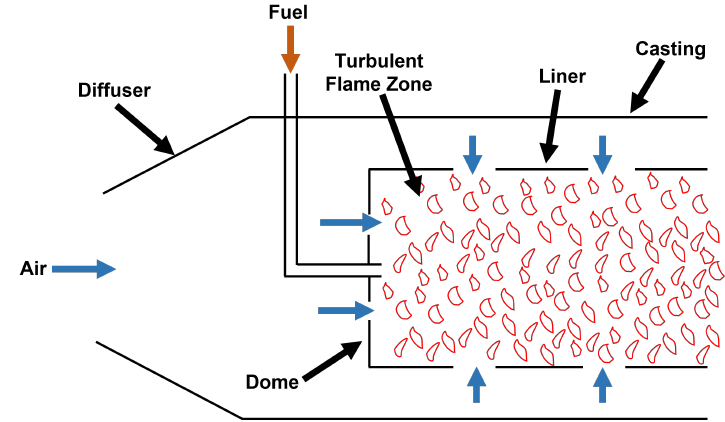
Figure 4. The physical model of Lefebvre’s LBO expression